Question: Write the caption for this figure.
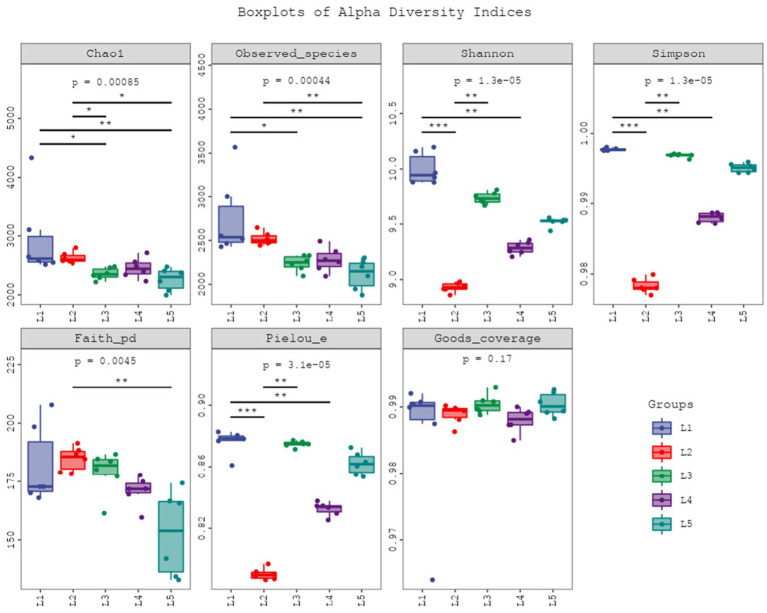
Answer: Alpha diversity index. L represents rumen fluid, and 1, 2, 3, 4, 5 represent sweet sorghum to aerial parts of licorice ratios of 100:0 (100%SS), 75:25 (75%SS), 50:50 (50%SS), 25:75 (25%SS), and 0:100 (0%SS), respectively. *indicates p < 0.05, **indicates p < 0.01.